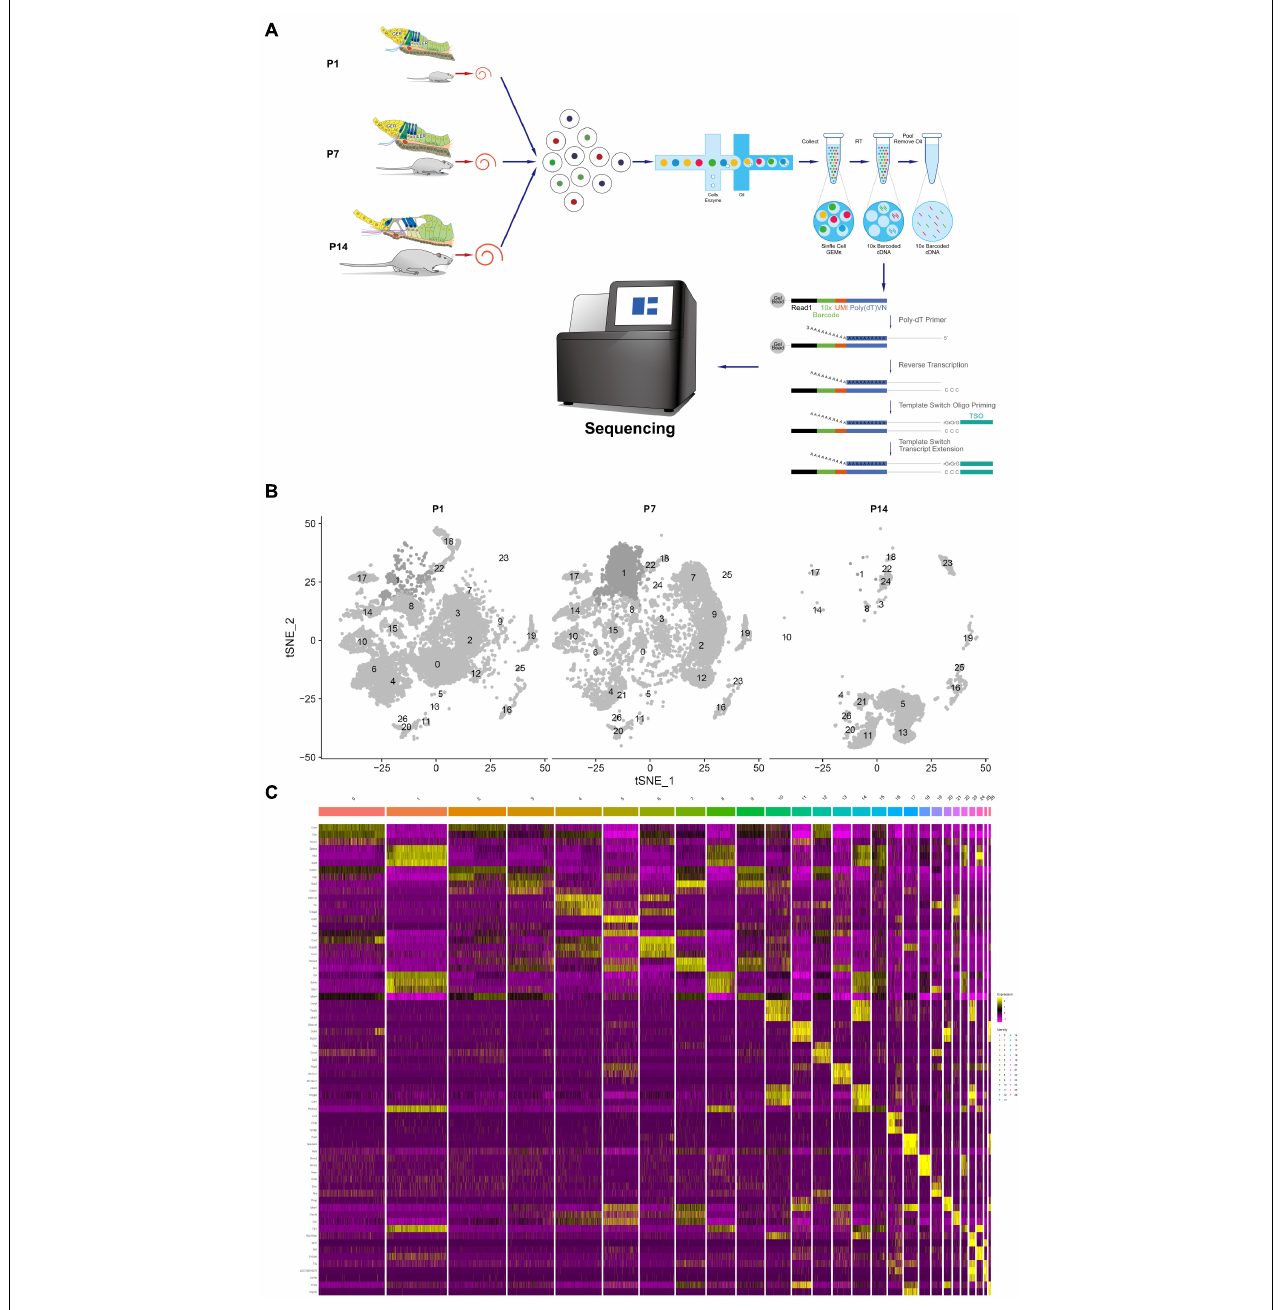
FIGURE 1 | Global expression profiling of cochlear duct cells by scRNA-Seq and cell clusters identification from P1, P7, and P14. (A) Cross-section diagrams of the cochlear canals, and the scheme of cochlear duct preparation, single-cell isolation, and Chromium 10 × Genomics library and scRNA-seq at P1, P7, and P14. (B) t-SNE plots of cochlear cell clusters at P1 (left), P7 (middle), and P14 (right) based on the origins (number) are shown. (C) Heat map for cochlear duct cell clusters. The top three differentials expressed (DE) genes for the 27 identified clusters are shown. Cellular identity for each cluster is indicated by a color bar at the top of the heat map. The color ranges from blue to bright yellow indicates low to high gene expression levels, respectively.